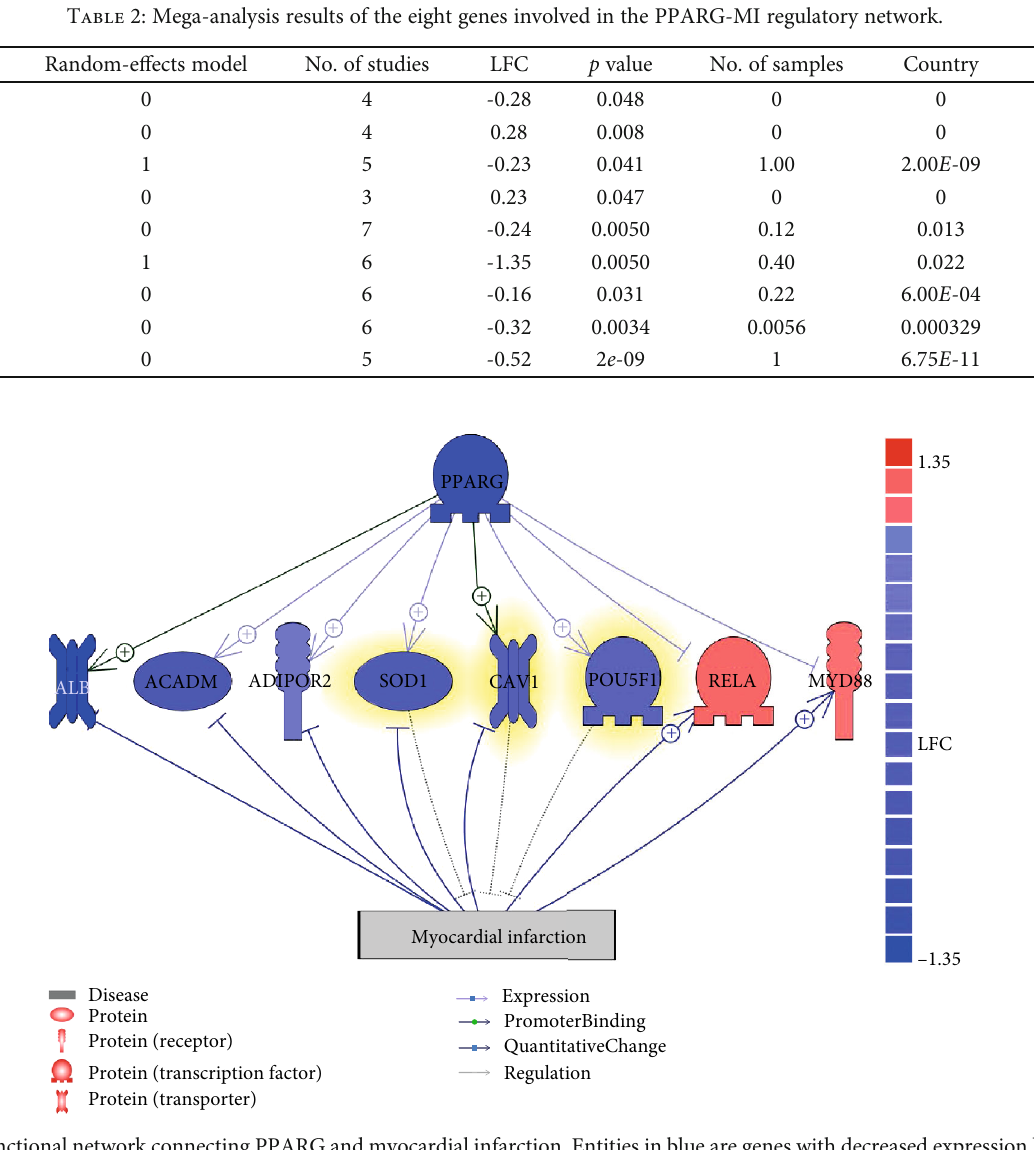
Figure 1: Functional network connecting PPARG and myocardial infarction. Entities in blue are genes with decreased expression levels from the mega-analysis using 8 MI datasets. Entities in red have an increased expression. Entities highlighted in yellow are genes regulating myocardial infarction, and the rest of the genes were targets regulated by myocardial infarction. + represents positive regulation; -| is